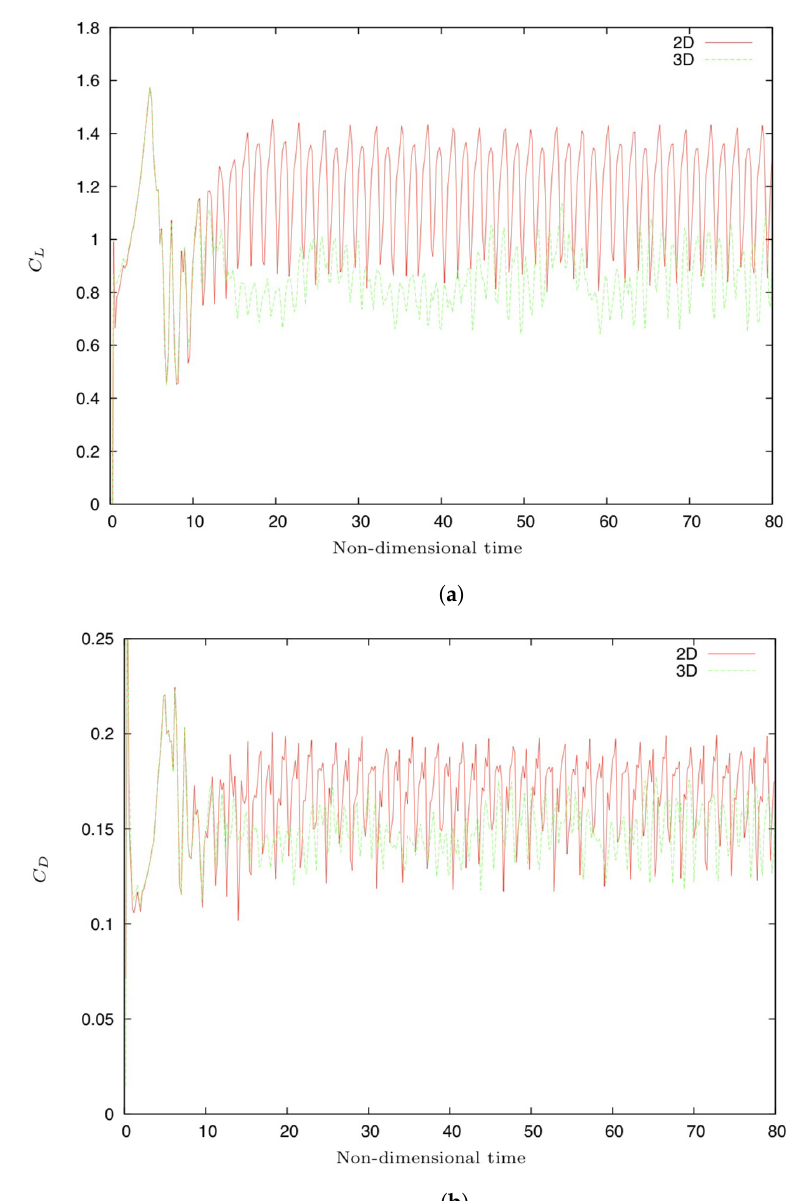
Figure 14. Time history of lift and drag coefficient of 2D and 3D calculations for the corrugated airfoil at Re = 4000 with angle of attack of 8 ◦ : ( a ) lift coefficient; and ( b ) drag coefficient. Figure 15 shows the instantaneous velocity field on the upper surface of the corrugated airfoil at angle of attack of 8 ◦ , Re = 4000. Figure 15a shows the velocity field viewed from diagonally upward, while Figure 15b shows the velocity field viewed from the front side. From this result, it was confirmed that the flow field around the corrugated airfoil is three-dimensional, especially in the separation shear